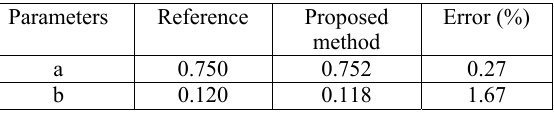
Table 4: Validations of free-form shape structure parameters.